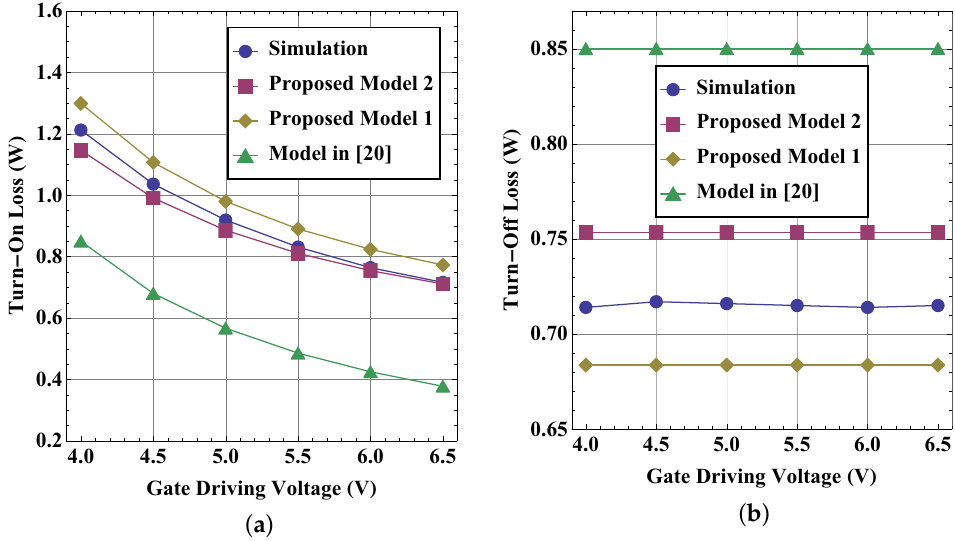
Figure 8. Switching loss of the models based on [20] at 10 MHz, 10 V input voltage, and 10 A load current: ( a ) turn-on loss as a function of gate driving voltage; ( b ) turn-off loss as a function of gate driving